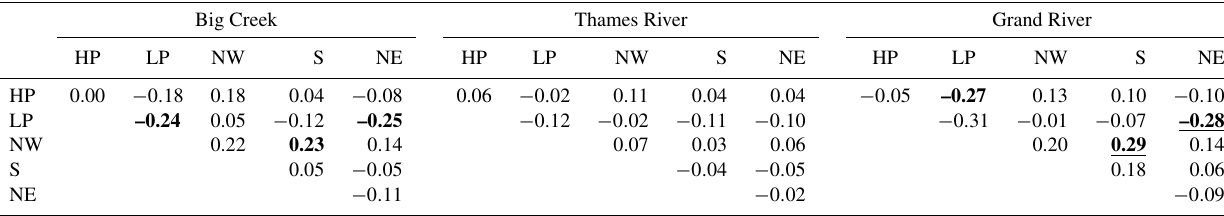
Table 2. Inter-member correlations between DJF change in occurrence of weather regimes and DJF change in number of high-flow events between 1961–1990 and 2026–2055. Bold text shows correlations significant at 90% according to the Pearson correlation table. Underlined text shows correlation significance at